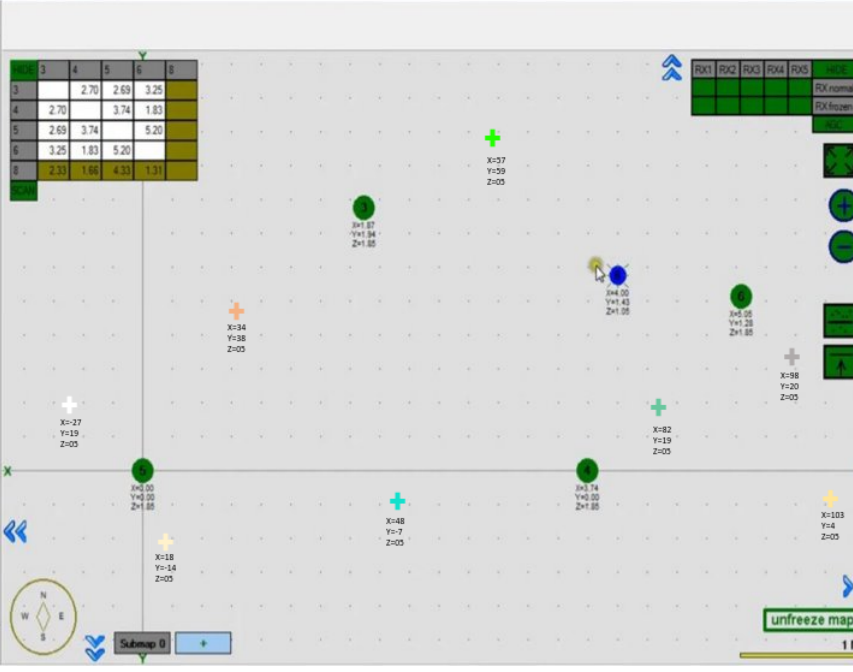
Figure 13. Beacon maps with static beacons and a mobile